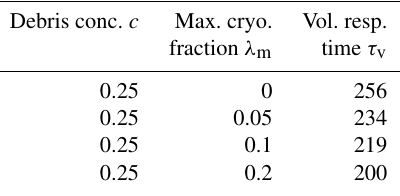
Table 4. Comparison of numerical e -folding volume response times (in years) due to step changes between ELA = 3000m and ELA = 3100m for a debris concentration of c = 0 . 25% and with the pres- ence of several different values of maximum terminal cryokarst fraction λ m . Debris conc. c Max.